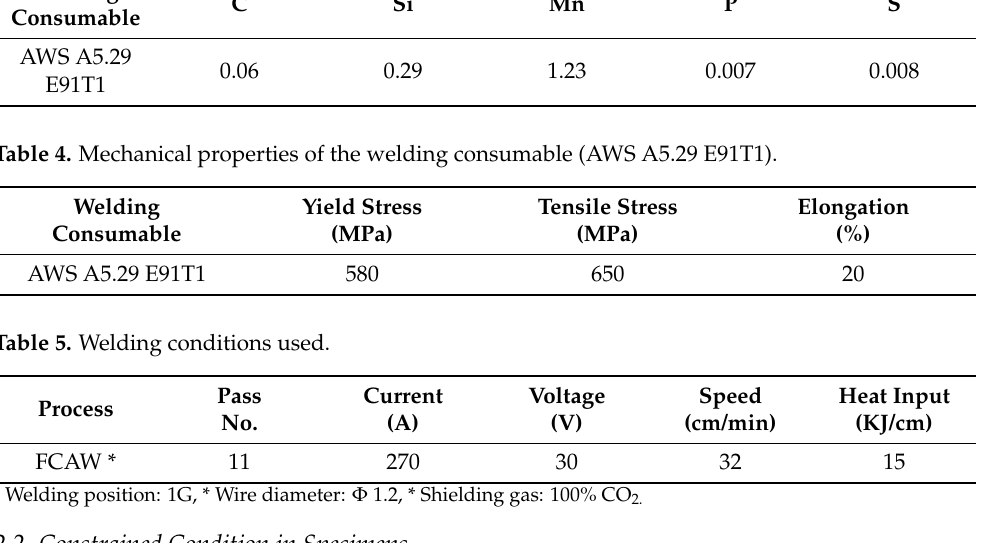
Table 3. Chemical composition of welding consumable (AWS A5.29 E91T1) (wt.%). Welding C Si Consumable